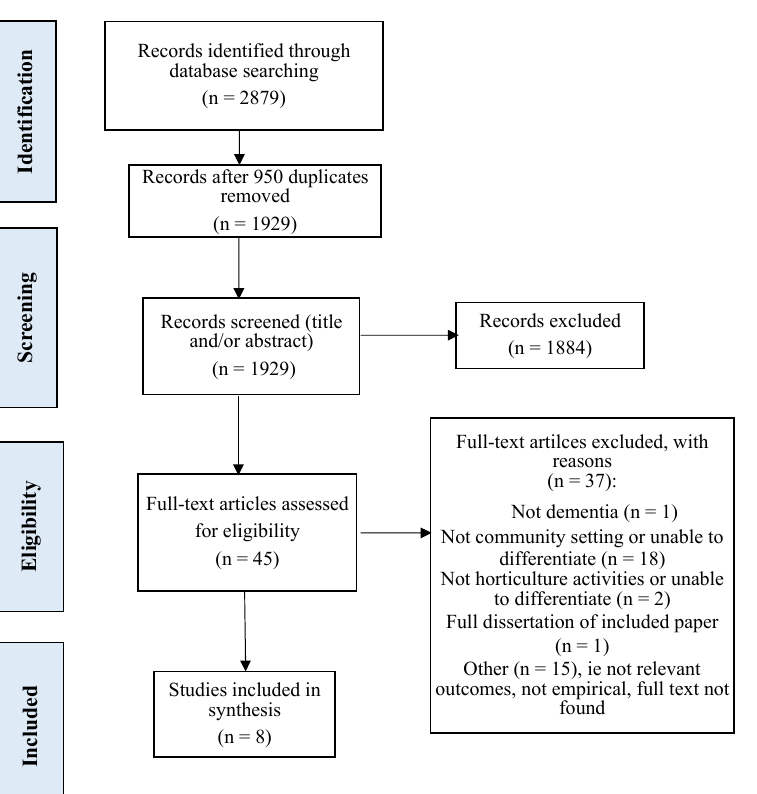
Figure 1. PRISMA flow diagram [40] for selection of papers.